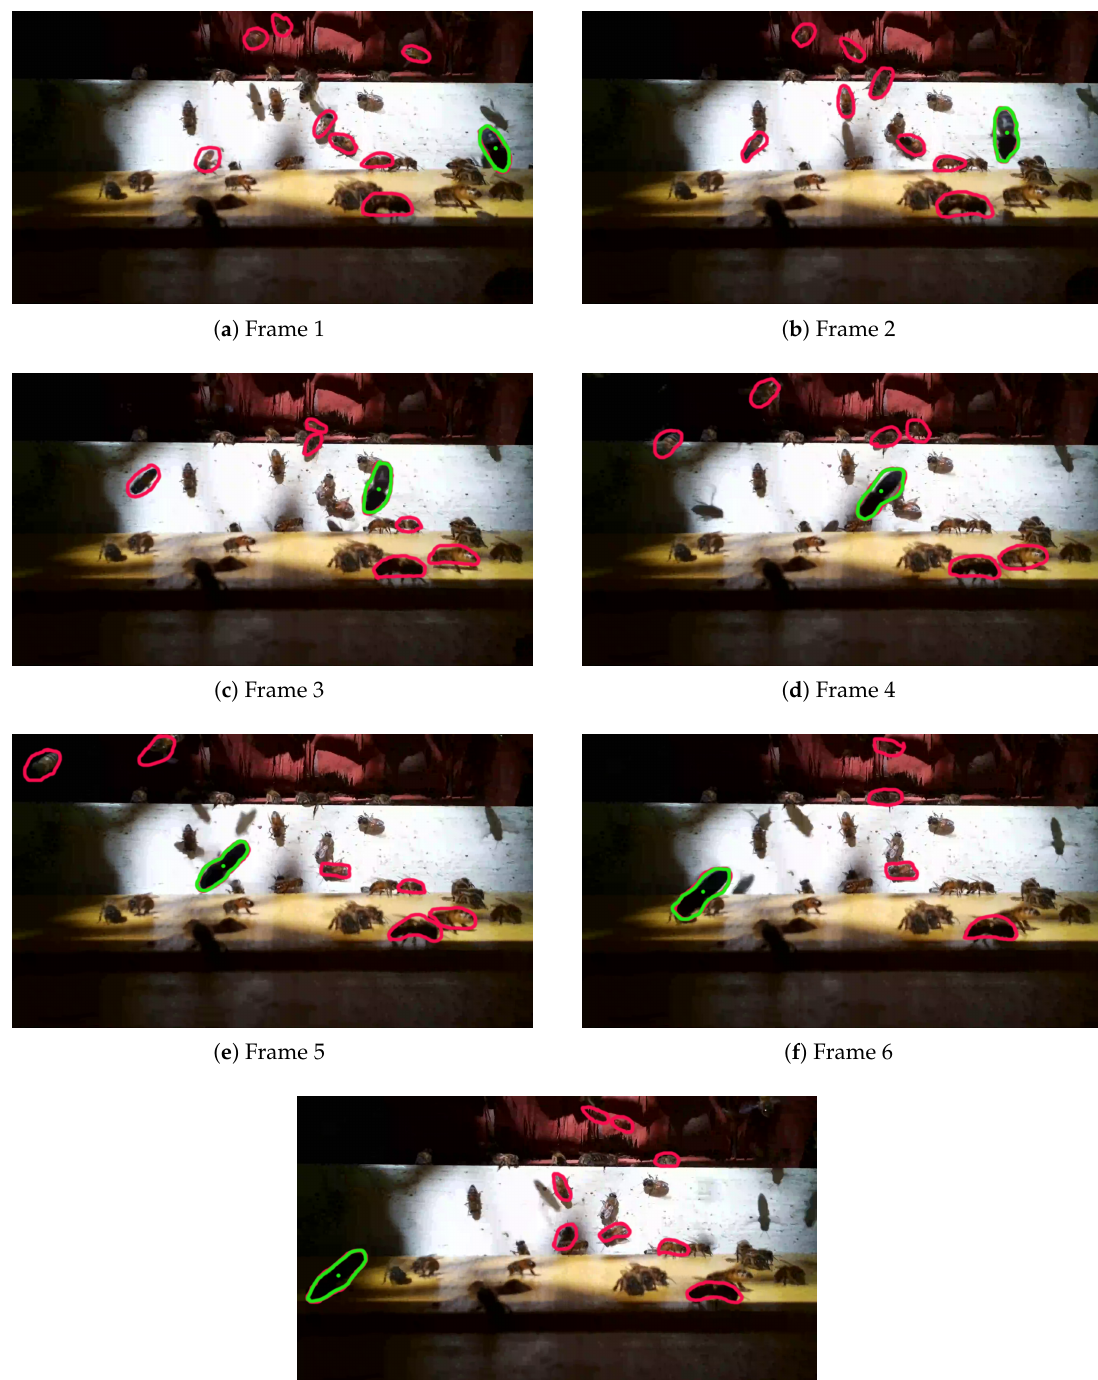
Figure A3. Seven consecutive frames from a high bee traffic video; the frames are numbered row by row from top left down as Frame 1–7; a fast moving bee is delineated in each frame by a green polygon; the bee is moving right to left; the x, y coordinates of the green dot in each polygon in the corresponding frames are: x = 507.0, y = 1782.0 in Frame 1; x = 448.5, y = 1569.0 in Frame 2; x = 427.5, y = 1351.5 in Frame 3; x = 433.5, y = 1104.0 in Frame 4; x = 486.0, y = 778.5 in Frame 5; x = 580.5, y = 444.0 in Frame 6; x = 660.0, y = 151.5 in Frame